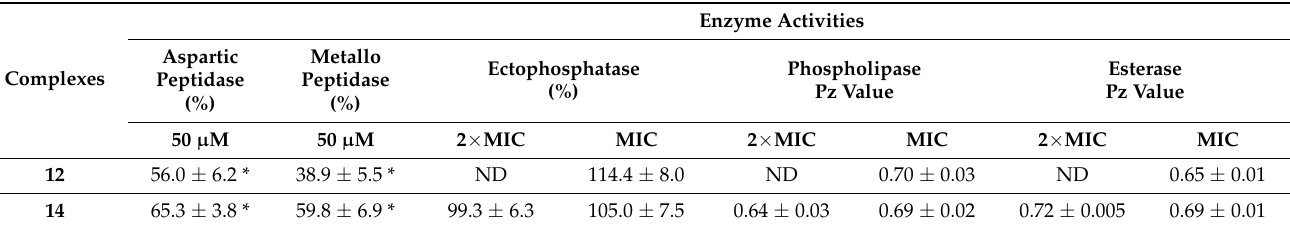
Table 4. Effect of silver complexes on F. pedrosoi enzymatic